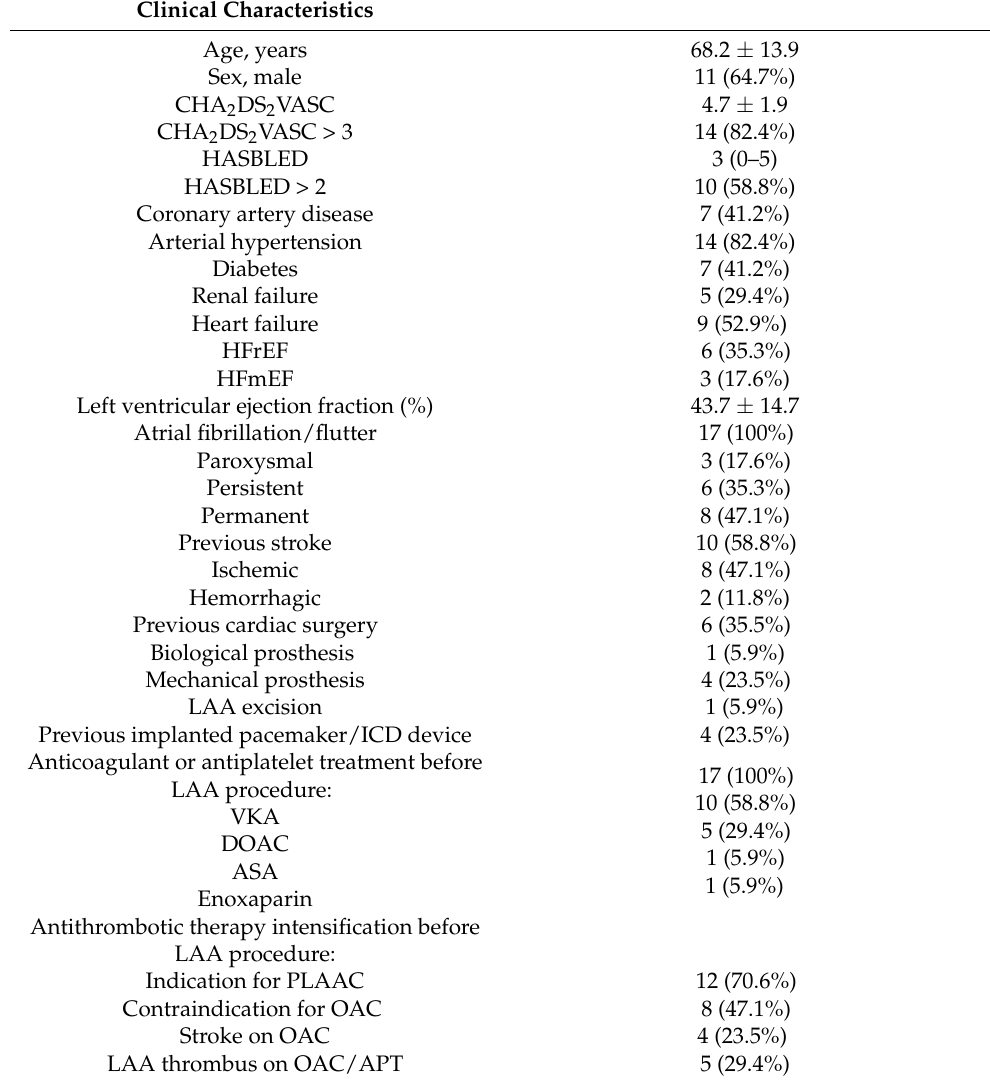
Table 1. Clinical characteristics of study